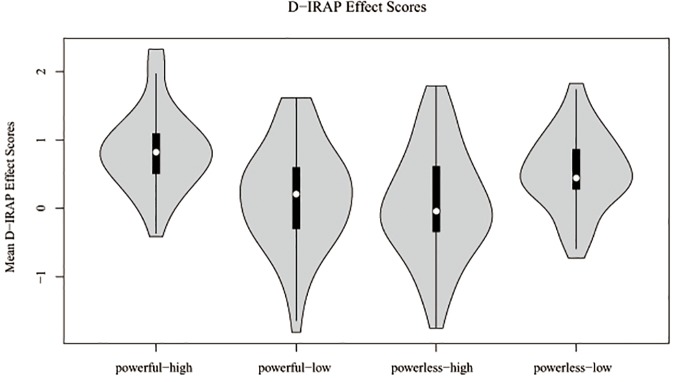
Mean Dirap effect scores.